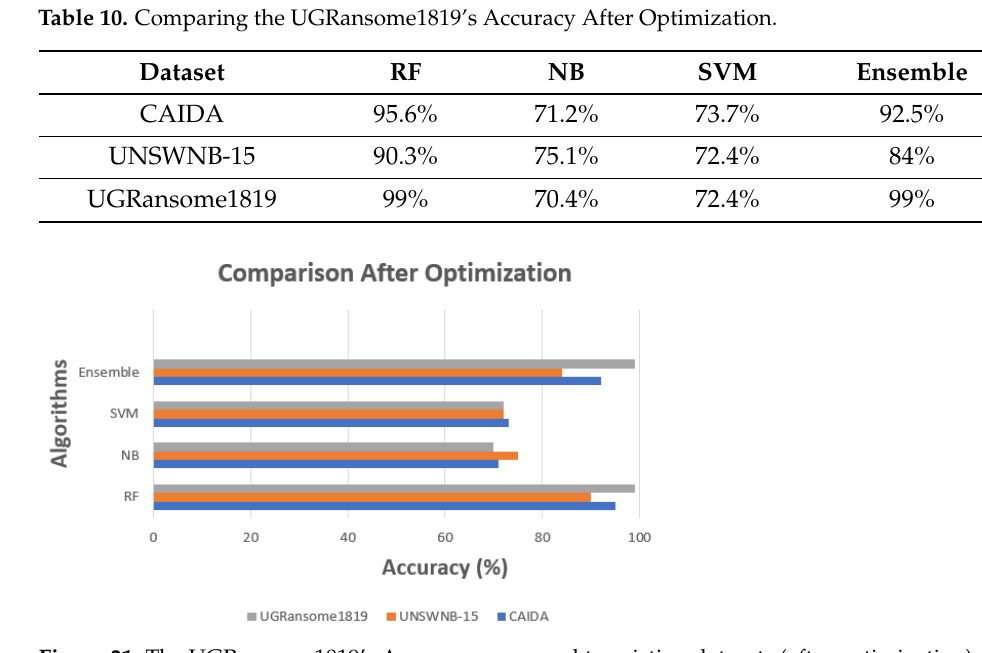
Figure 21. The UGRansome1819’s Accuracy compared to existing datasets (after